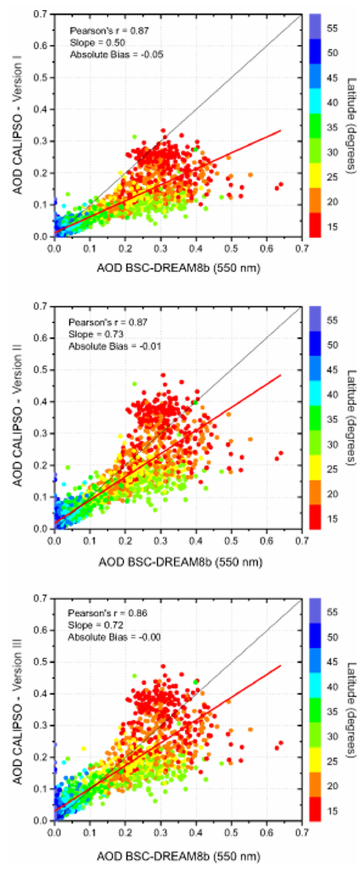
Fig. 8. Comparison of CALIPSO and BSC-DREAM8b dust AODs for (upper) original Version I CALIPSO AODs, (middle) Ver- sion II CALIPSO AODs for LR equal to 58sr, (lower) Version III CALIPSO AODs for LR equal to 58sr and acknowledgment of non- dust aerosol types (extinction equal to zero) in the averaging scheme as well as pure dust component contained in dust and polluted dust types. Color bar represents the latitudinal zone of the comparison, in 5 ◦